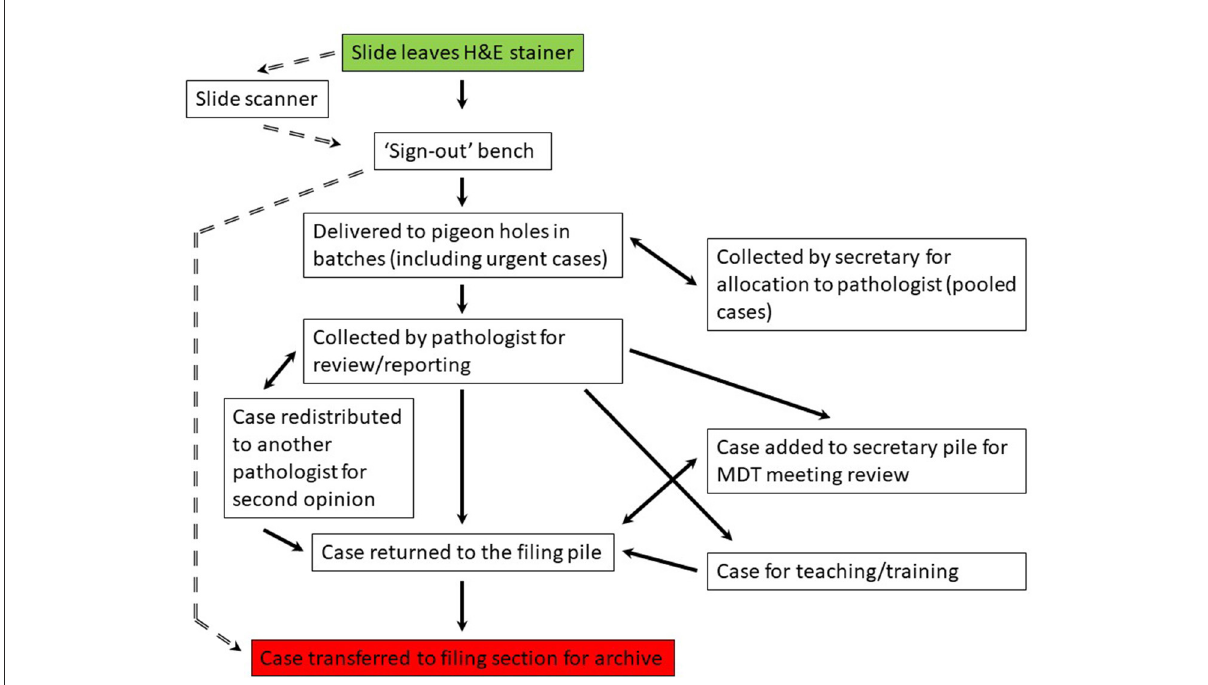
FIGURE1 Process map for the laboratory workflow for a case from the point at which it is ready for pathology review to the return of the case for archiving following provision of a histology report. The analog workflow is on the right (solid arrows) and the predicted digital workflow is on the left (broken arrows). Start point (green) and end point (red) are the same for the analog and digital workflow. MDT, multidisciplinary team. Pigeon hole (PH) is the collection point for a diagnostic case by a pathologist, each having their own designated